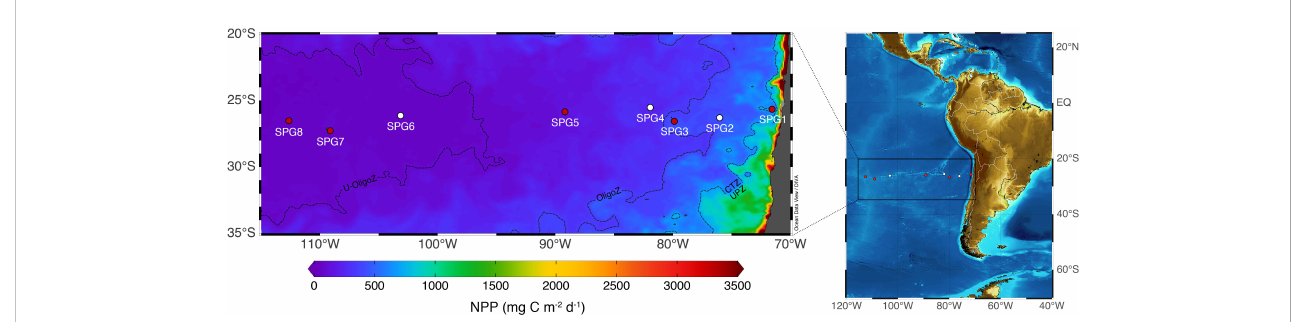
FIGURE 1 Transect surveyed across the Southeast Paci fi c Ocean during the EPIC cruise (February 2019). Circles stand for those stations where size-fractionated plankton samples were collected for stable isotope analyses in the bulk material (all stations) and in the amino acids (red circles). Monthly averaged net primary production (NPP, left panel) was derived from remote sensing data available at the Ocean Productivity site (http://www.science.oregonstate.edu/ ocean.productivity) and following the vertical generalized production model (VGPM) developed by Behrenfeld and Falkowski (1997). The 4 oceanographic regions described in Gonza ́ lez et al. (2018) are delimited by black dashed